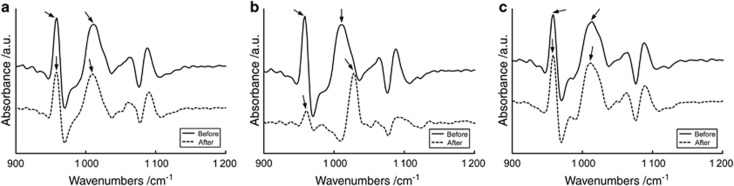
Representative spectra that were initially second-derivative transformed and then multiplied by −1 before (solid line) and after (dotted line) erosion treatment. (a) DW; (b) CC; (c) YA. The arrows indicate ν1 (left) and ν3 (right) PO4 regions. a.u., arbitrary unit; CC, coca-cola classic; DW, deionized water; YA, activia drinks plain.